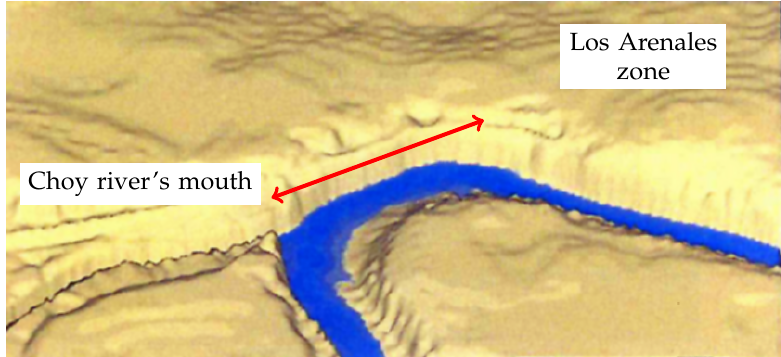
Figure 13. First region to be protected by civil work around Zone (A) (see Figure